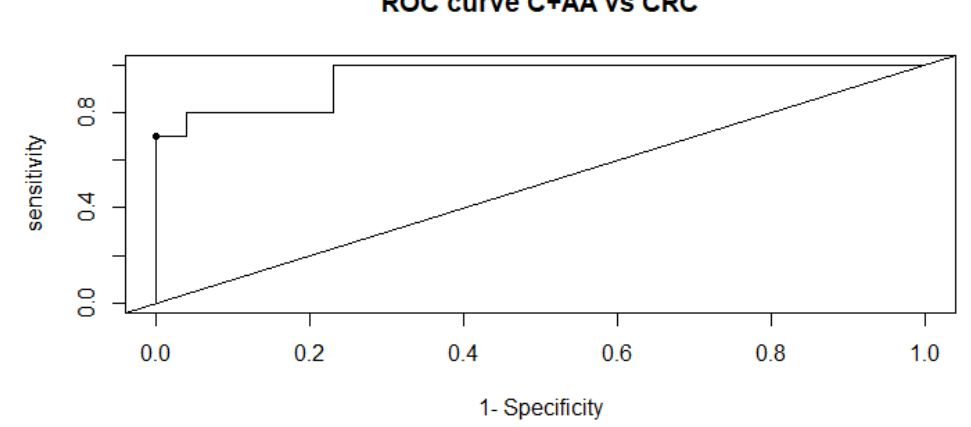
Figure 2. ROC curve of predictive model using logistic regression with Hgb and predicted metabo- lites.